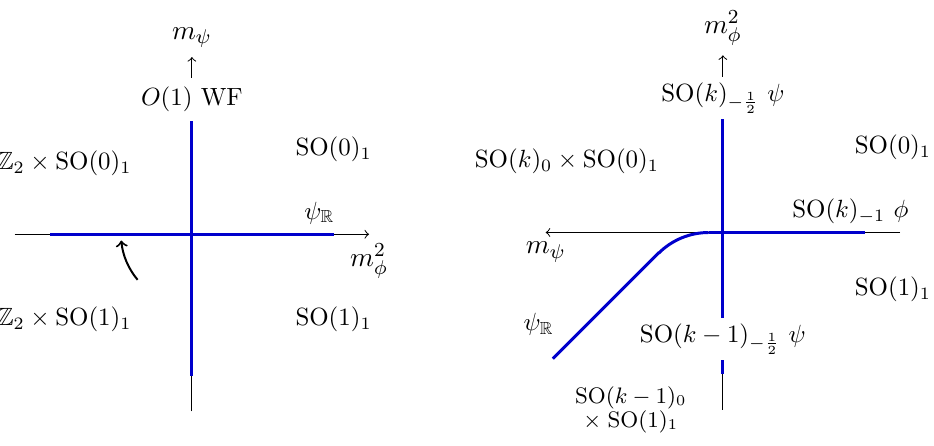
Figure 9 . O (1) WF